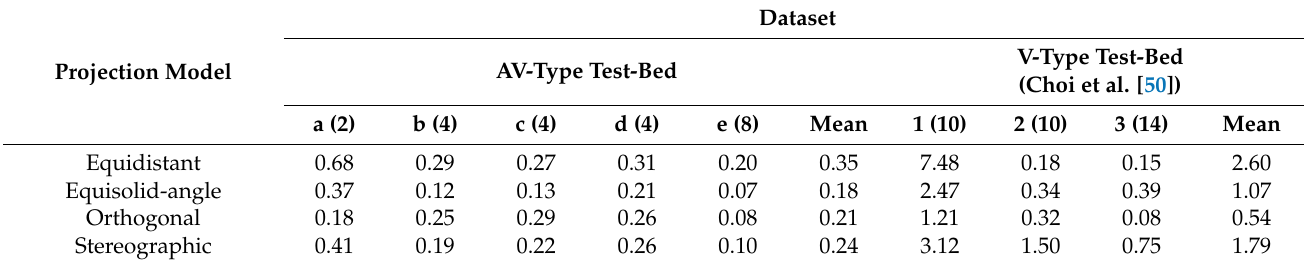
Table 17. Comparison of RMSE values of lens distortion (pixel).